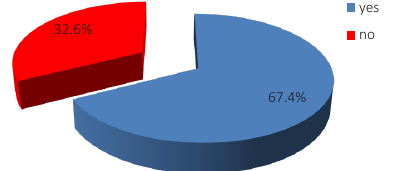
Figure 5. Perception of Risk of Acquiring Infections While Abroad.